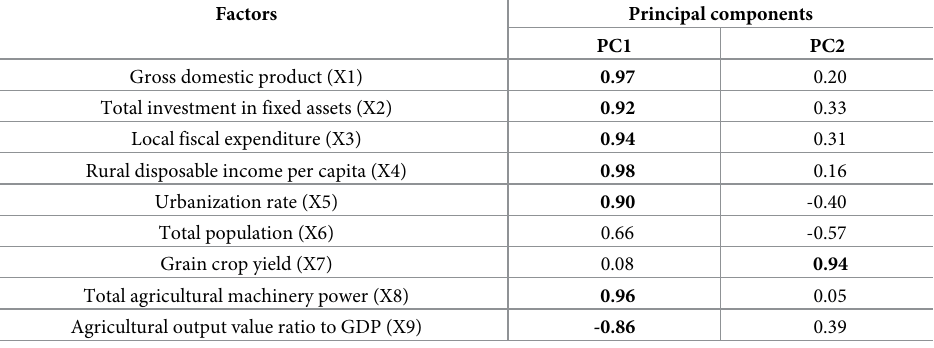
Table 3. Load matrix of the principal